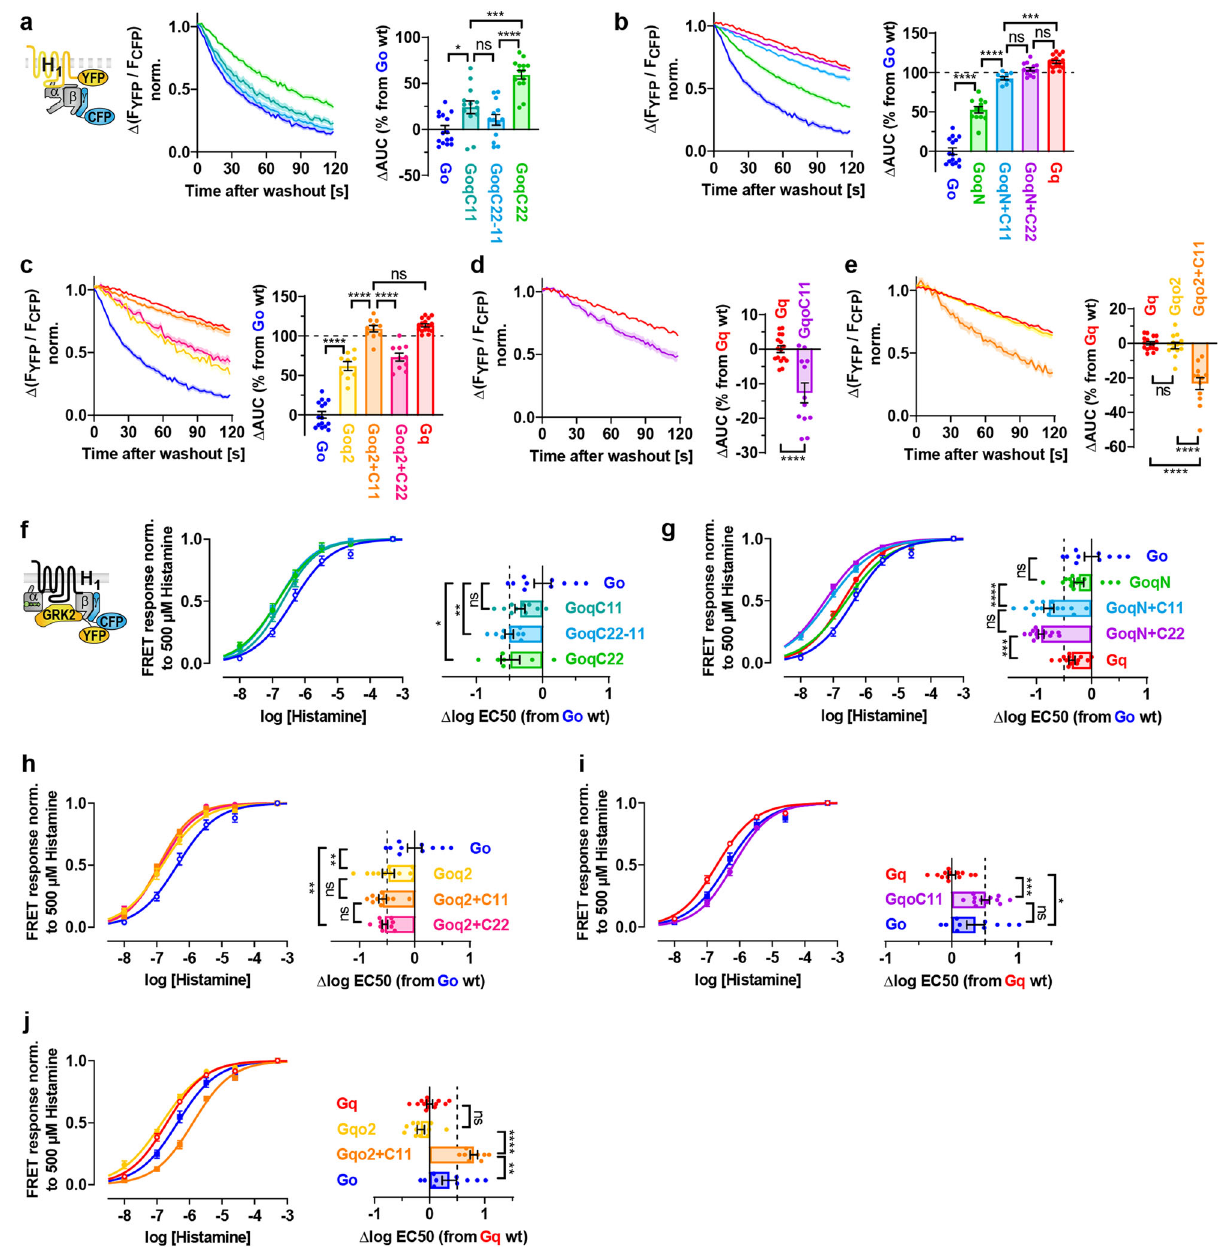
Fig. 5 Binding and activation measurements of chimeric Goq and Gqo subunits with H1 receptors. a – e G protein binding experiments of chimeric Goq and Gqo subunits with H 1 receptors were performed in analogy to Fig. 1b but transfected with C-terminally mCitrine-labeled H 1 R instead of mCit-labeled M 3 R and stimulated with 100 µ M histamine instead of 10 µ M ACh. Dissociation kinetics of H 1 R-G protein complexes were quanti fi ed by determining the AUC as described in Fig. 1b and plotted in the bar graphs as relative changes of the AUC from Go in a – c and from Gq in d – e . ( a Go; n = 15, GoqC11; n = 13, GoqC22-11; n = 13 and GoqC22; n = 14. b GoqN; n = 12, GoqN + C11; n = 10, GoqN + C22; n = 13, Gq; n = 16 and Go; n = 15 duplicated from a. c Goq2; n = 9, Goq2 + C11; n = 10, Goq2 + C22; n = 10, Go; n = 15 duplicated from a and Gq; n = 16 duplicated from b . d GqoC11; n = 12 and Gq; n = 16 duplicated from b . e Gqo2; n = 12, Gqo2 + C11; n = 12 and Gq; n = 16 duplicated from b ). f – j Indirect G protein activation measurements were performed in analogy to Fig. 2a, b but transfected with H 1 R instead of M 3 R and stimulated with the maximum of 500 µ M histamine instead of 500 µ M CCh. Individually calculated EC50 values were plotted in horizontal bars as relative changes from the averaged EC50 values of Go in f – h and of Gq in i – j . ( f Go; n = 10, GoqC11; n = 10, GoqC22-11; n = 9 and GoqC22; n = 7. g GoqN; n = 15, GoqN + C11; n = 15, GoqN + C22; n = 14, Gq; n = 13 and Go; n = 10 duplicated from f . h Goq2; n = 11, Goq2 + C11; n = 10, Goq2 + C22; n = 9 and Go; n = 10 duplicated from f . i GqoC11; n = 12, Gq; n = 13 duplicated from g and Go; n = 10 duplicated from f . j Gqo2; n = 11, Gqo2 + C11; n = 8, Gq; n = 13 duplicated from g and Go; n = 10 duplicated from f ). All data points are represented as means ± SEM and colored as indicated in the corresponding bar graphs. Statistical analyses were performed using one-way ANOVAs followed by Tukey ’ s posttests ( a – j , * P < 0.1, ** P < 0.01, *** P < 0.001, **** P < 0.0001, ns if P ≥ 0.05).